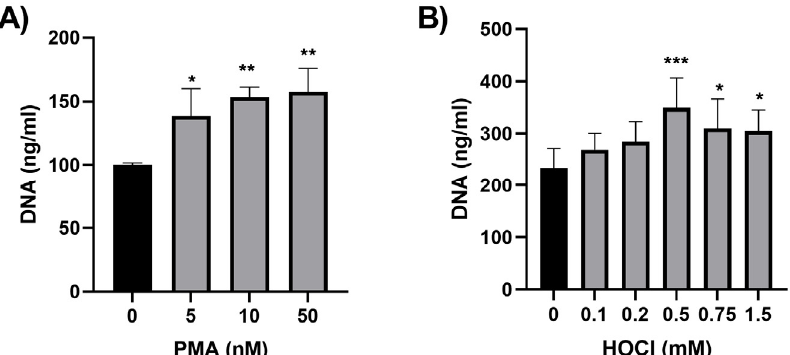
Figure 1. PLB-985 cells treated with PMA or HOCl release DNA into the extracellular space. Differentiated PLB-985 cells (1 × 10 6 cells/mL) were treated with ( A ) PMA (0–50 nM) and ( B ) HOCl (0–1.5 mM) for 4 h before quantification of NET release by addition of DNase (40 U, 15 min) and determination of extracellular DNA using the Quant-iT TM PicoGreen TM dsDNA assay kit. Data are the mean ± S.E.M. of 3–6 experiments. *, ** and *** indicate a significant ( p < 0.05, 0.01, 0.001) change on comparing the PMA- or HOCl-treated cells to the non-treated control by one-way ANOVA with Dunnett’s multiple comparisons test.